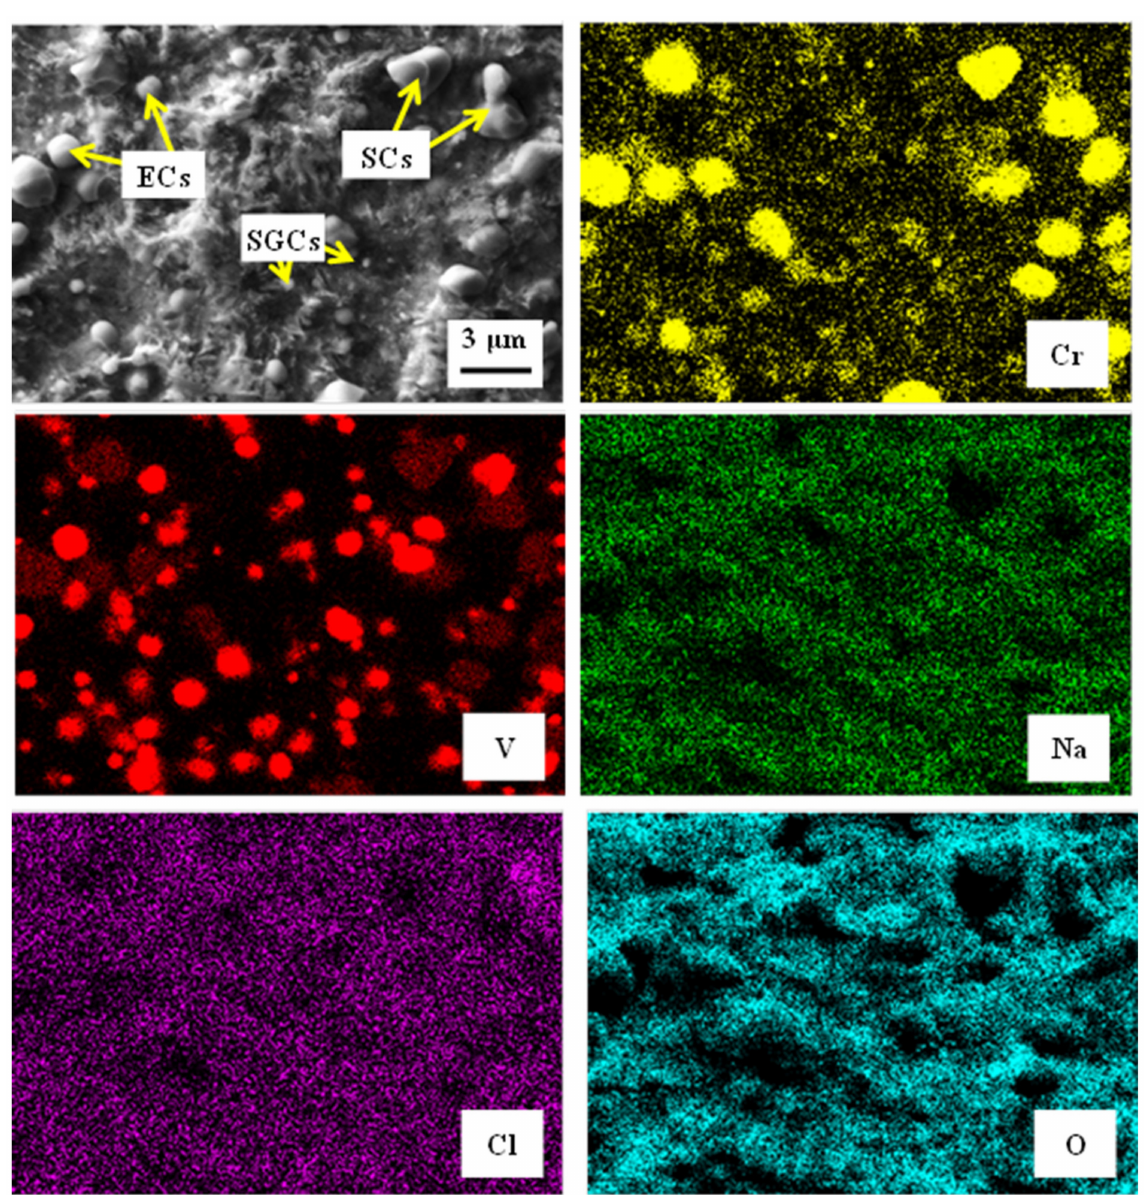
Figure 13. SEM micrograph showing the surface of the specimen that was subjected to the SZT at − 140 ◦ C, after the potentiodynamic polarisation measurements, and corresponding EDS maps of Cr, V, Na, Cl, and